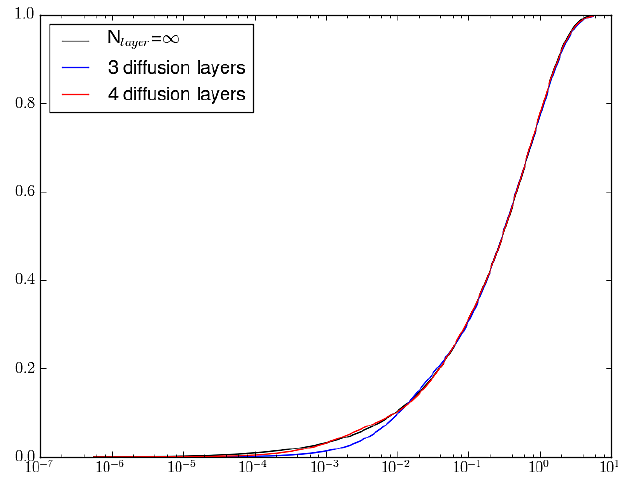
Figure 1. Evolution of the ratio A p (t)/A eq as a function of the ratio t/τ dif